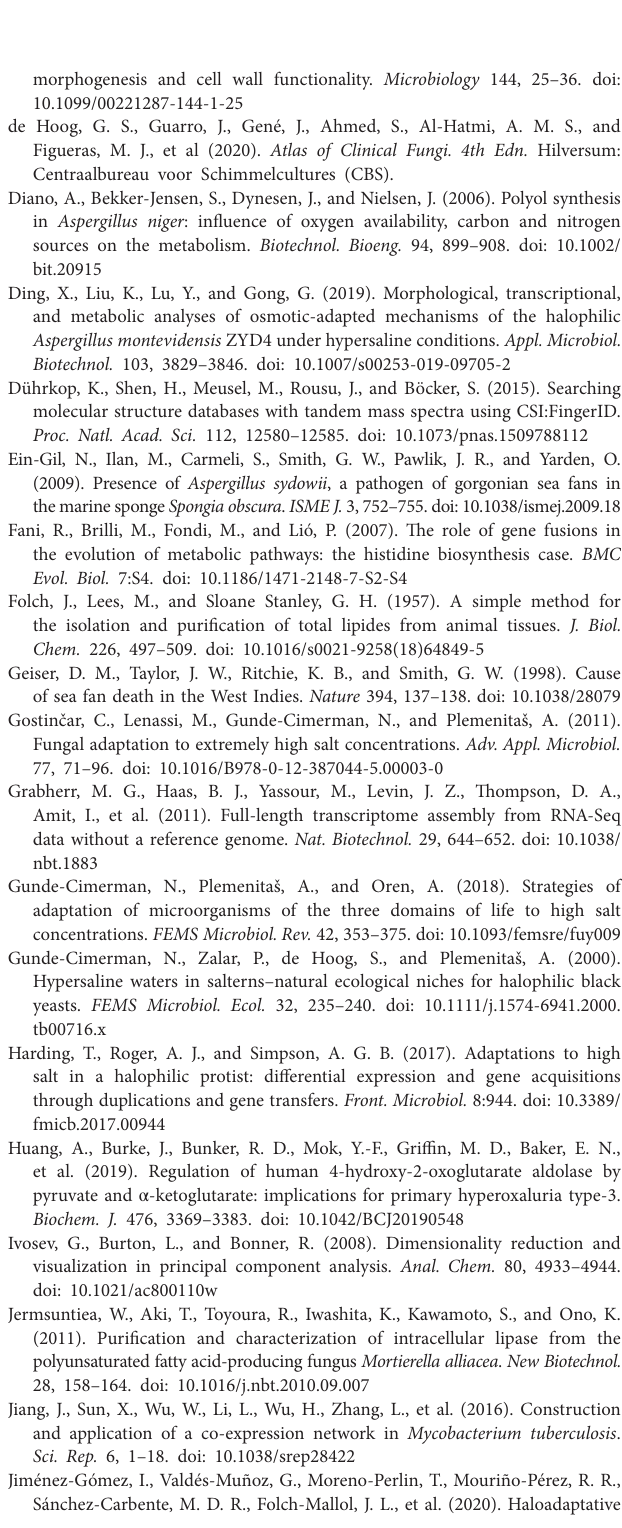
compatible solutes, cell wall, pheromone synthesis, cellular membrane transporters, calcium pathway, and morphology at 5.13 M NaCl compared to 1 M